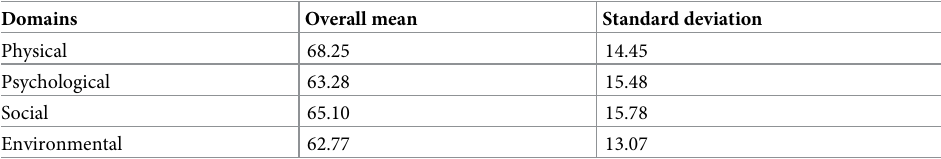
Table 3. Domain-specific score averages of the study